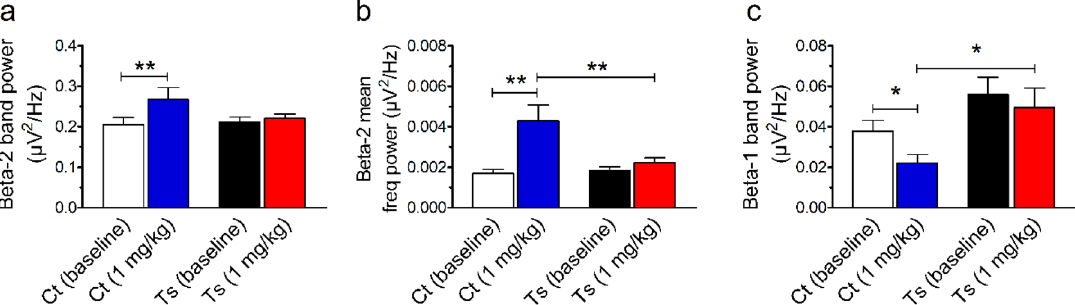
Figure 2. Ts65Dn mice show altered beta-band neuronal activity responses when compared to control euploid mice. ( a ) Diazepam at 1-mg/kg dose significantly increased beta-2 band power in control but not in Ts65Dn mice. ( b ) Diazepam-treated control mice showed an increase in the power of the beta-2 mean frequency compared to its baseline condition and diazepam-treated Ts65Dn mice. ( c ) Diazepam-treated control mice also showed a lower beta-1 band power than its baseline condition and diazepam-treated Ts65Dn mice. Number of mice: Ct baseline (N = 6), Ct 1 mg/kg diazepam (N = 6), Ts baseline (N = 7), and Ts 1 mg/kg diazepam (N = 7). Data represent mean ± SEM. Statistical significance is expressed as * and ** for P < 0.05 and P < 0.01,